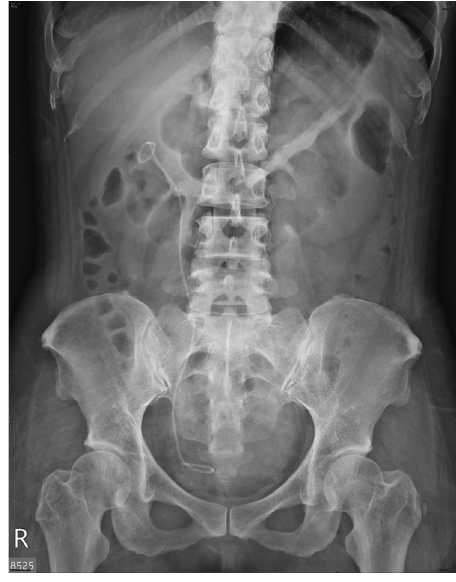
Figure 6: Postoperative KUB showed disappearance of the radio - paque lesion at right kidney area. Right double J ureteral stent were in situ